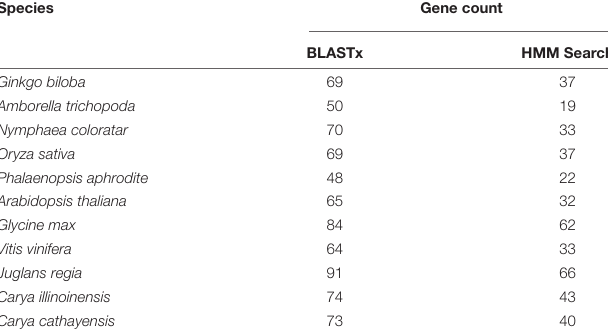
TABLE 1 | Identified TLP gene count after the program of BLASTx and HMM Search in 11